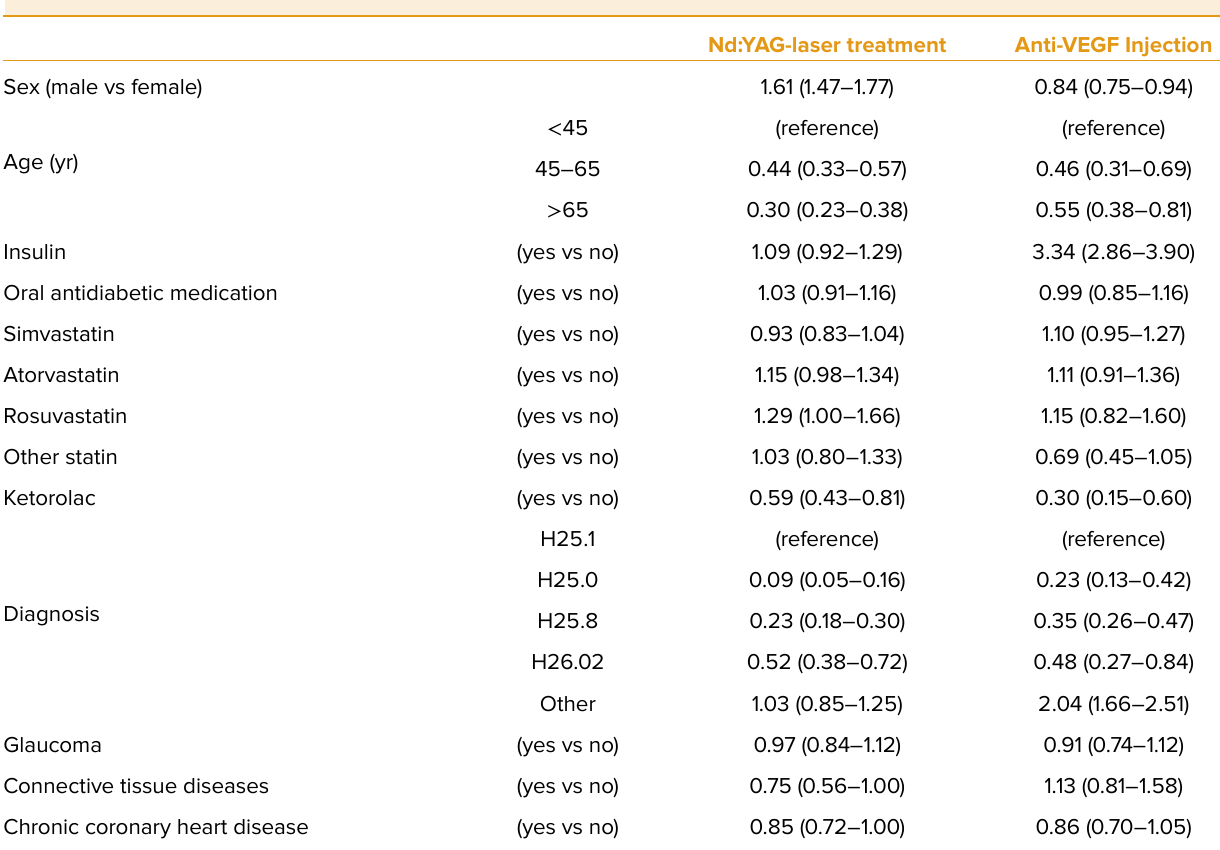
Table 3. Incidence rate ratios (with 95% confidence intervals) based on Poisson regression model. Adjusted for calendar year and time since start of